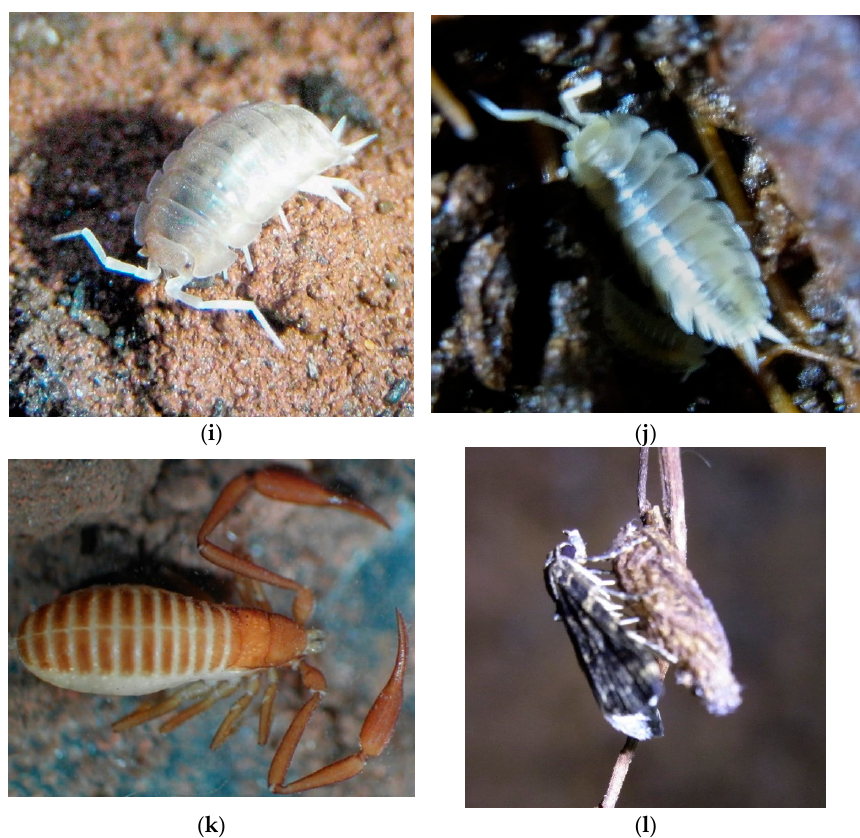
Figure 7. Bayliss Cave troglobionts and subterranean plant: ( a ) scutigeromorph centipede, photo F.G. Howarth; ( b ) Millipedes on bait, photo F.G. Howarth; ( c ) ectobiid cockroach Neotemnopteryx baylissensis Slaney, 2000, photo G. Thompson, Queensland Museum; ( d ) nocticolid cockroach Nocticola sp. 1, photo G. Smith; ( e ) cixiid planthopper Solonaima baylissa Hoch and Howarth, 1989, photo H. Reimer; ( f ) whisk fern, Psilotum sp. photo F.G. Howarth. ( g ) reduviid Peirates sp. preying on cockroach, N. baylissensis , photo F.G. Howarth; ( h ) atelurine silverfish, Pseudogastrotheus undarae Smith, 2016, photo G. Smith; ( i ) Bayliss Cave isopod, cf. Porcellionidae, photo J. Sydney; ( j ) Pinwill Cave isopod, photo J. Sydney; ( k ) pseudoscorpion, Protochelifer sp. nr. cavernarum Beier, 1967, photo A. Clarke; ( l ) Erebid moth, cf. Schrankia sp. adult with cocoon on tree root, photo G.